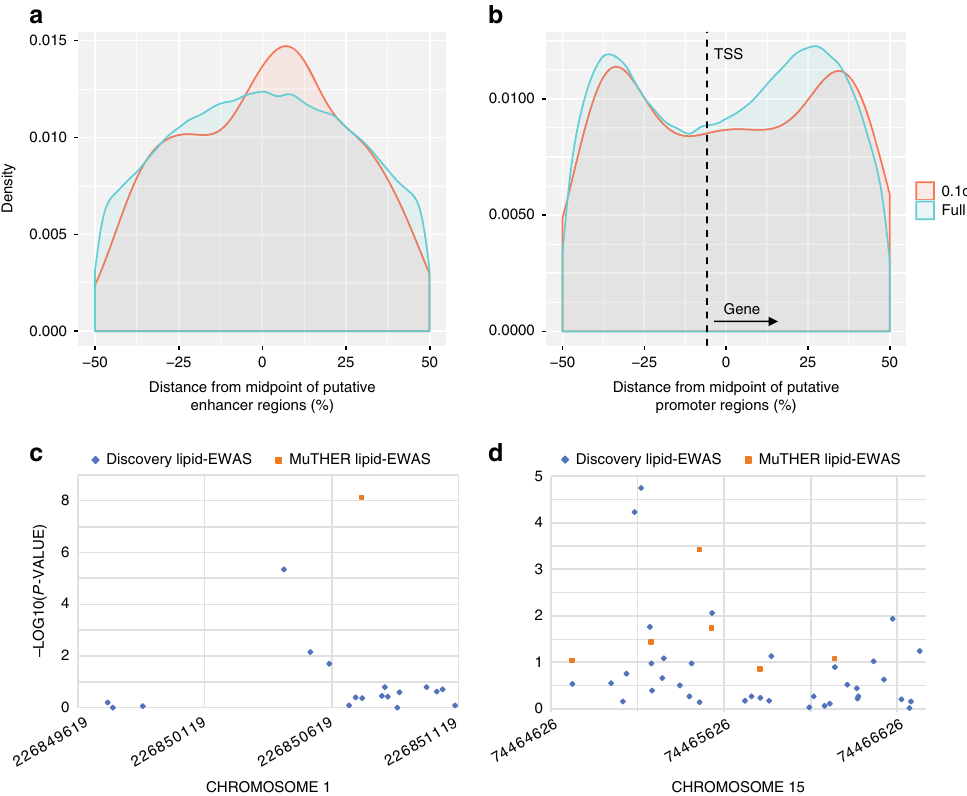
Fig. 2 Positional mapping of lipid-CpGs within adipose tissue regulatory elements. Speci fi c positional trends of signi fi cant lipid-CpGs (FDR 10%) merged across all studied lipids traits (i.e., triglycerides, HDL-C, LDL-C, and total cholesterol) were investigated at adipose regulatory regions. Positions of CpGs were tabulated as the percent distance from the midpoint of elements (genomic distance from midpoint (bp)/length of element(bp)*100) and collapsed to summarize positional trends over all assessed elements. Positional trends are shown for a CpGs mapping to LMRs ( N = 225,771) and b CpGs mapping to UMRs within + / − 1.5 kb of transcription start sites (TSS) not depicting bivalent gene transcription orientations (taking gene orientation into account; N = 418,246). The fi ne-mapping potential of MCC-Seq over array-based methods is exempli fi ed in c a replicated HDL-linked enhancer region (chr1:226849619- 226851122) and d a replicated LDL-linked promoter region (chr15:74464626-74466792), where we noted top discovery lipid-CpGs to mimic trends noted in a and b at adjacent sites to signals identi fi ed from the large-scale 450K-based MuTHER